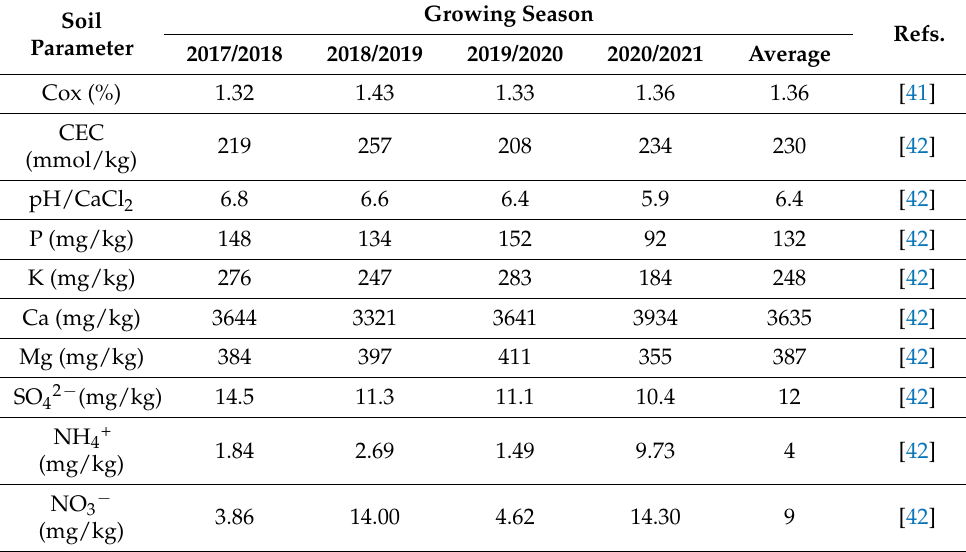
Table 1. The physical–chemical properties of the soil. Soil